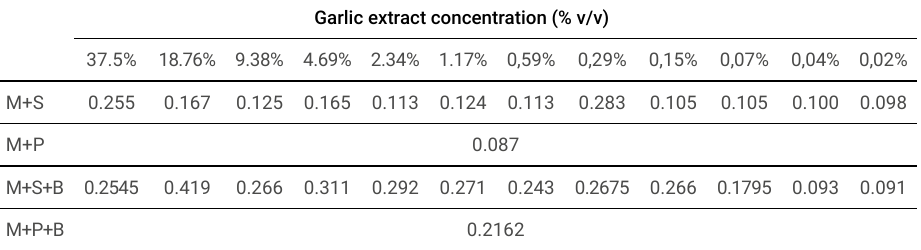
Table 2. Results of the Minimum Biofilm Inhibitory Concentration (MBIC). Garlic extract concentration (% v/v)